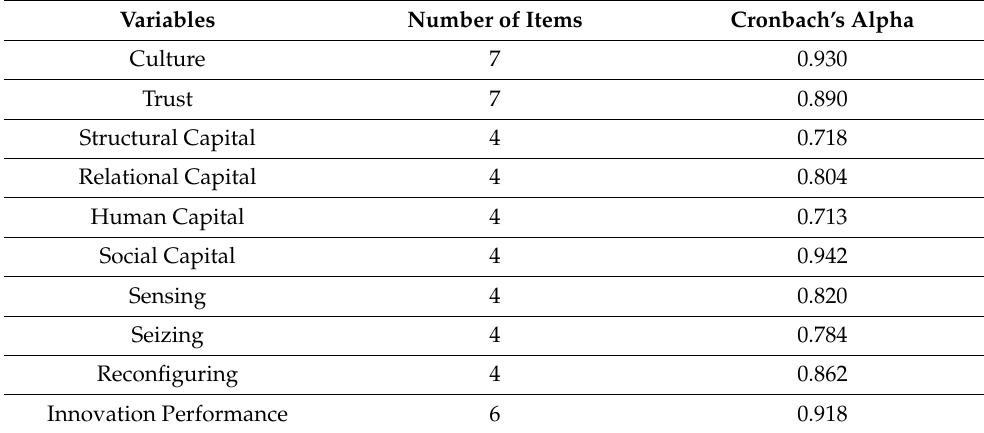
Table 1. The results obtained from the pilot